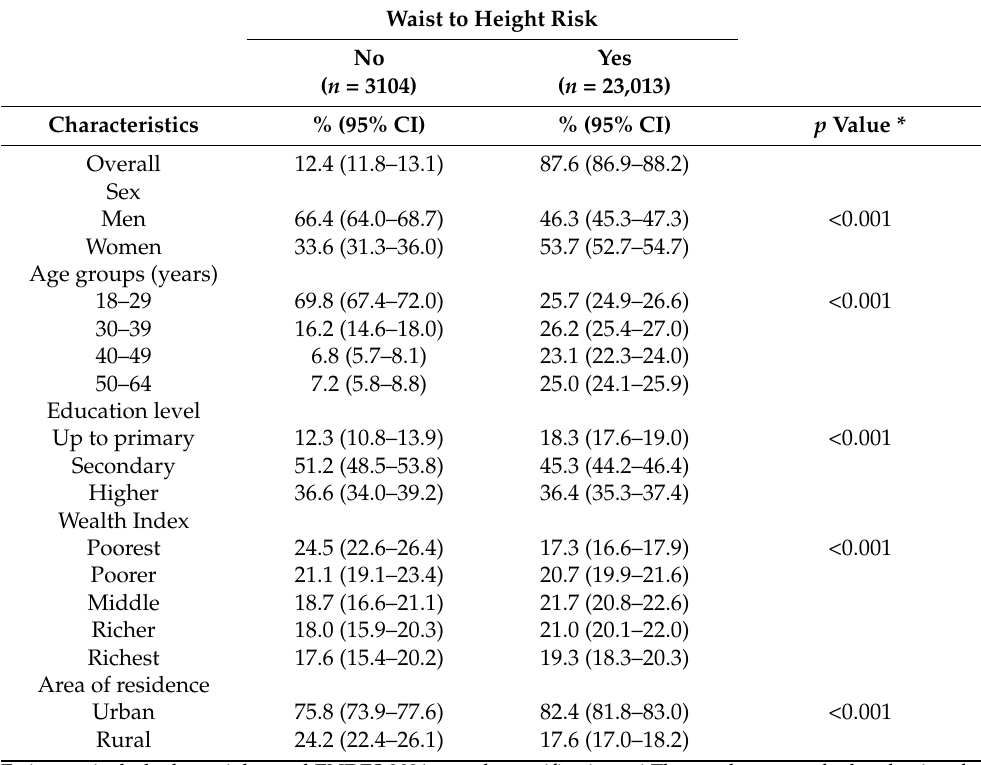
Table 3. Characteristics of the participants according to weight–height ratio.